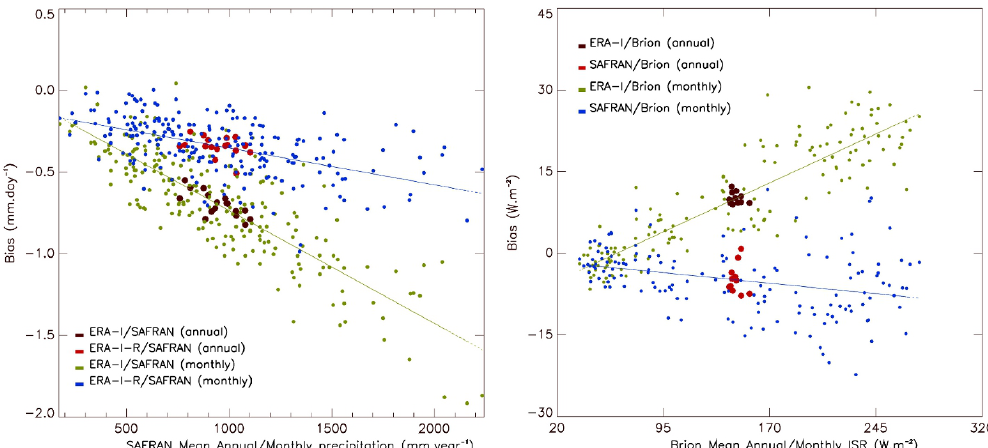
Fig. 13. Biases vs. reference values: (left) precipitation ERA-I and ERA-I-R biases vs. SAFRAN over the 1991–2008 period, (right) ISR ERA-I and SAFRAN biases vs. Brion over the 1995–2006 period. Large and small dots are for annual and monthly values, respectively. Regression lines correspond to monthly